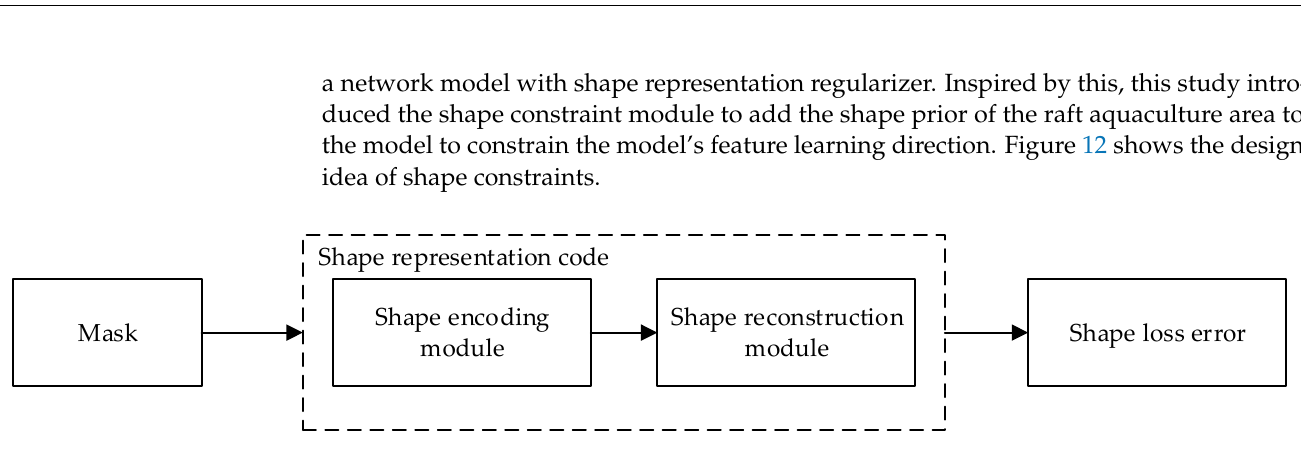
Figure 12. Schematic diagram of the overall flow of shape constraints.